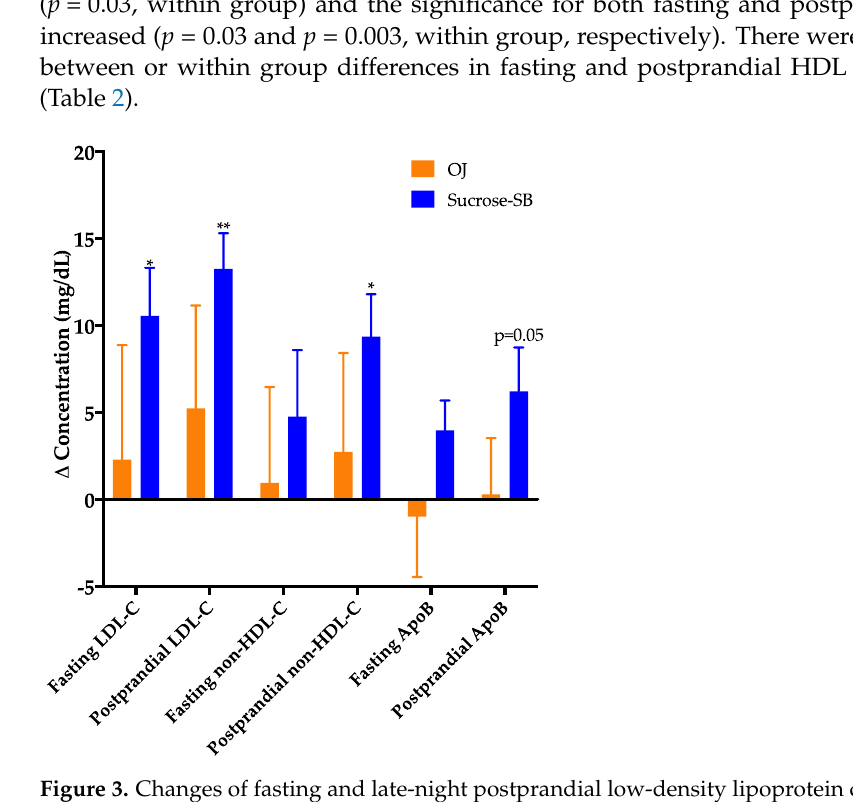
Figure 3. Changes of fasting and late-night postprandial low-density lipoprotein cholesterol (LDL- C), non-high-density lipoprotein cholesterol (non-HDL-C) and apolipoprotein B (ApoB) in women consuming either naturally-sweetened OJ (orange bars) or sucrose-SB (blue bars) for two weeks. * p < 0.05, ** p < 0.01, LS mean of change different from zero, primary ANCOVA.